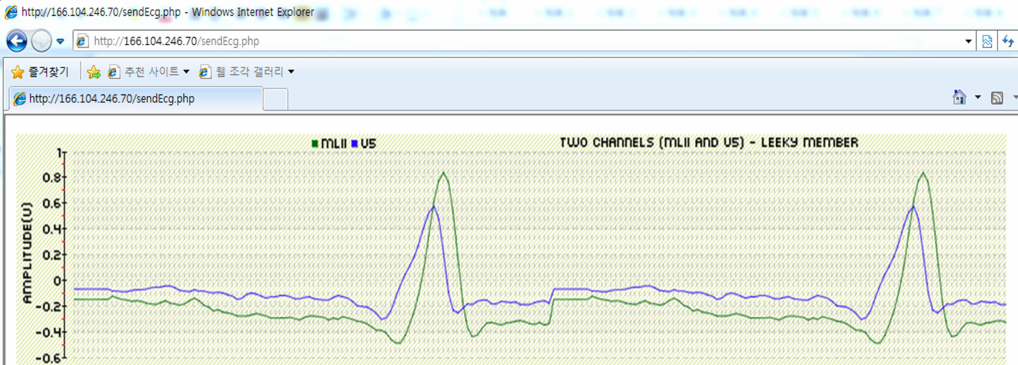
Figure 7. Results of web application